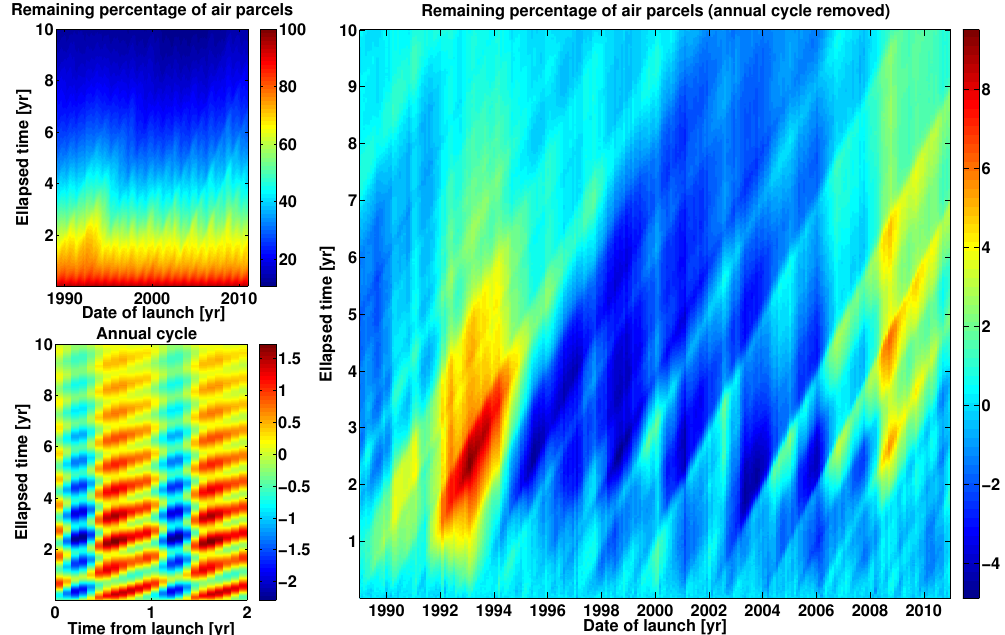
Fig. 8. Upper left: percentage of remaining parcels as a function of time and ellapsed time. Lower left: annual cycle in the percentage shown over two cycles. Right: percentage of remaining parcels after removal of the mean and annual cycle for each ellapsed age.